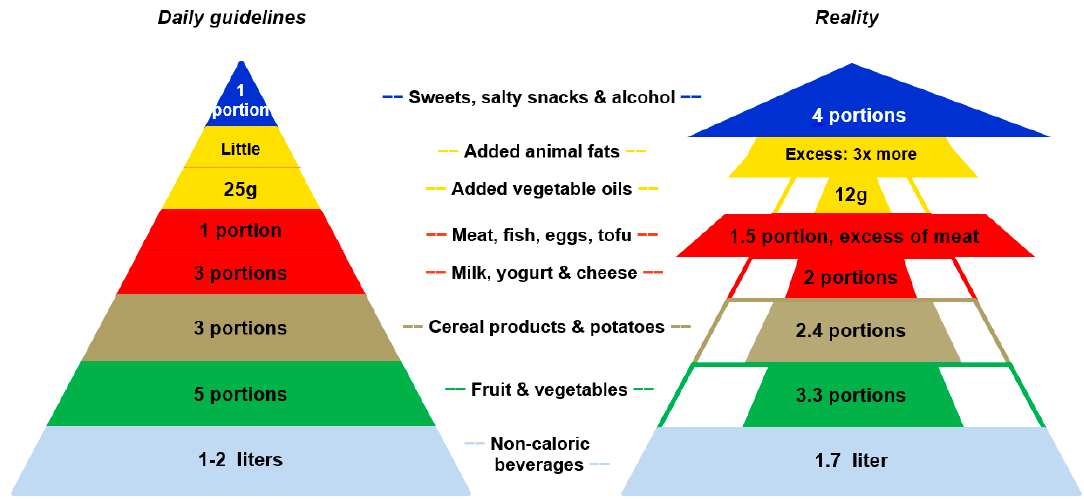
Figure 2. The daily national food-based dietary guidelines (i.e., Swiss Food Pyramid) ( left ) compared to the actual food consumption for the six stages at a population level ( right ).